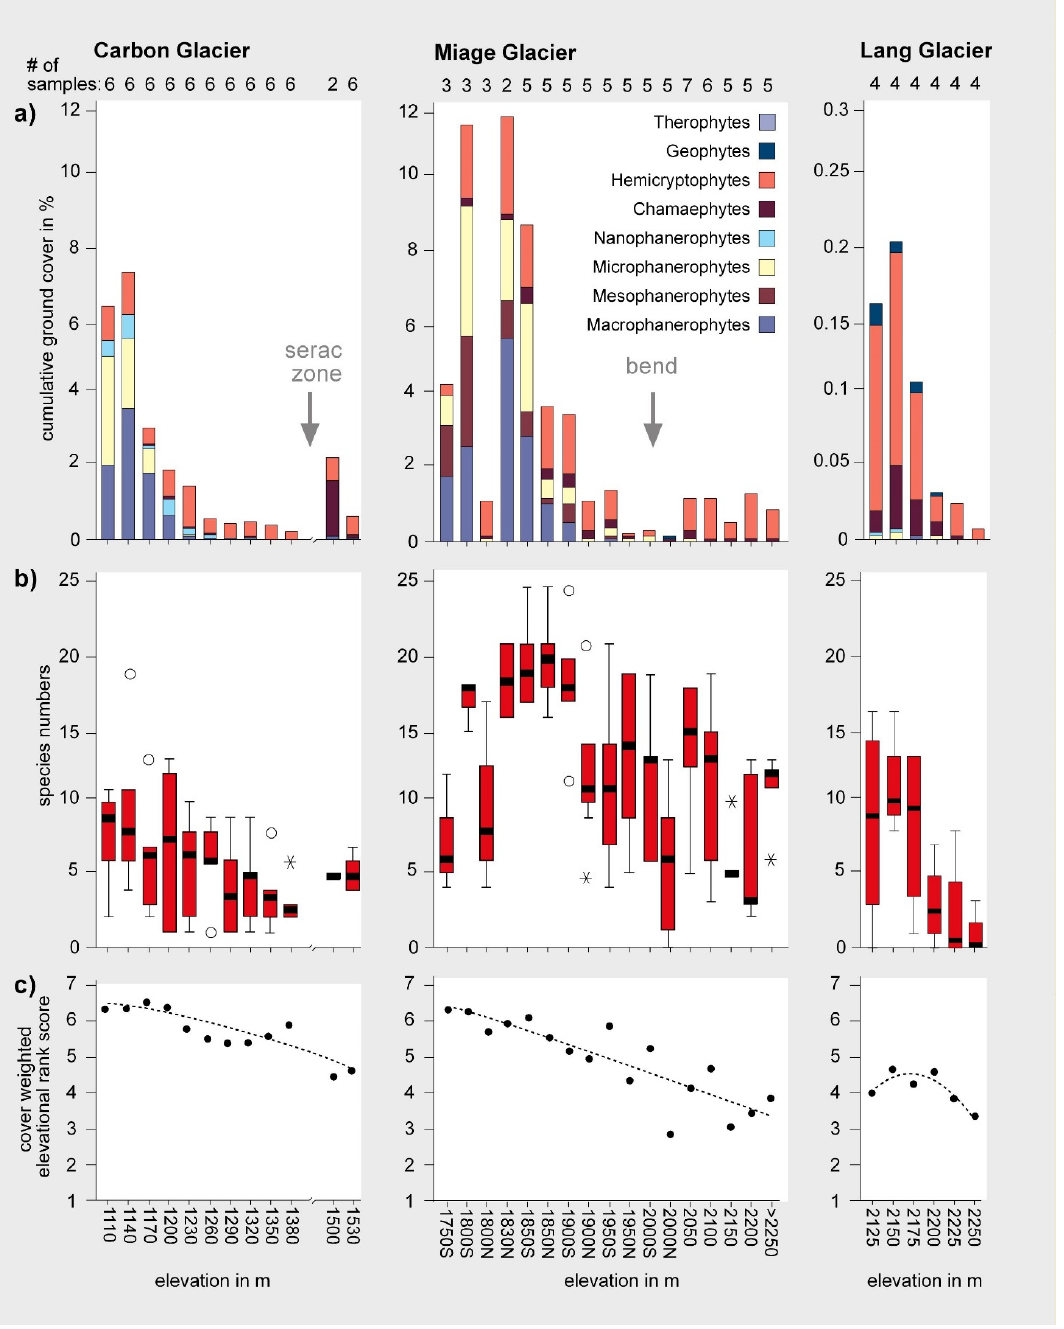
Figure 10. Gradual changes in vegetation structure and diversity measures from the glacier termi- nus upwards for the three mid-latitude DCGs—Carbon Glacier (terminating in the montane belt), Miage Glacier (terminating in the subalpine belt) and Lang Glacier (terminating in the alpine belt): ( a ) Life-form spectra, showing the contribution of individual life-forms to the mean total ground cover of vascular plants per sample location. ( b ) Boxplots for vascular plant species number per sample location showing the minimum and maximum values, the range of the middle half of the scores (25th to 75th percentile) and the median and outliers, if present. ( c ) Cover-weighted elevational rank score S for each sample location, based on the elevational rank values of vascular plants as displayed in Figure 8 and calculated using the formula in [106] (see also Appendix